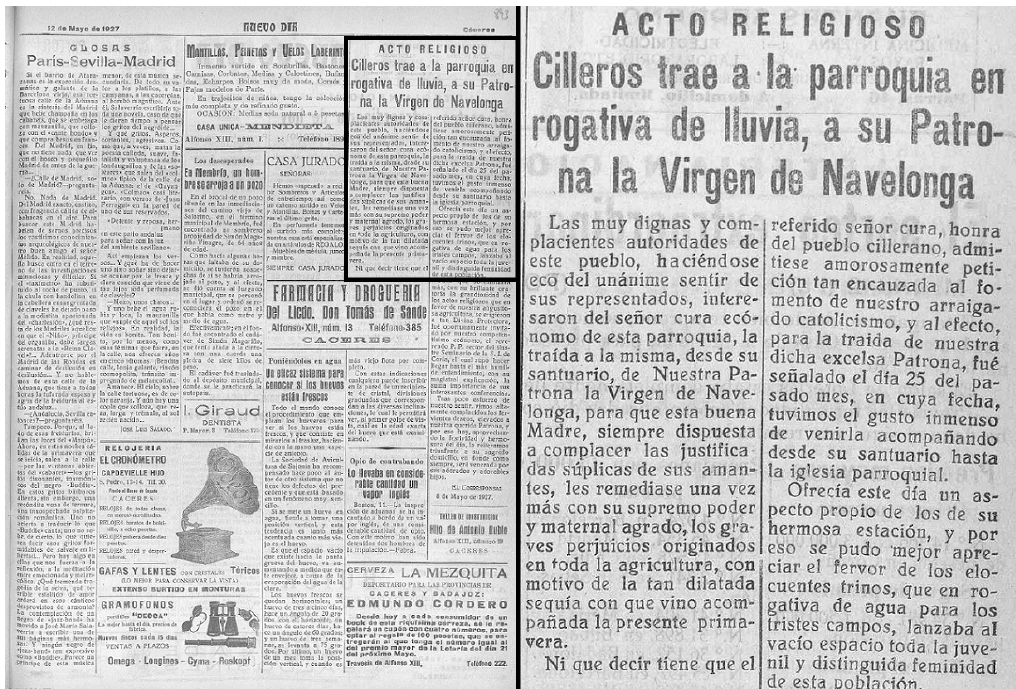
Figure 3. An example of a rogation ceremony registered in the newspaper Nuevo día: diario de la provincia de Cáceres in May 1927 in Cilleros (north of Extremadura) and it can be read: “Religious act. Cilleros brings its patron saint, the Virgin of Navelonga, to the parish in a prayer for rain. […] severe damages occurred in agriculture, due to an extensive drought that is taking place during the current spring. […]”.